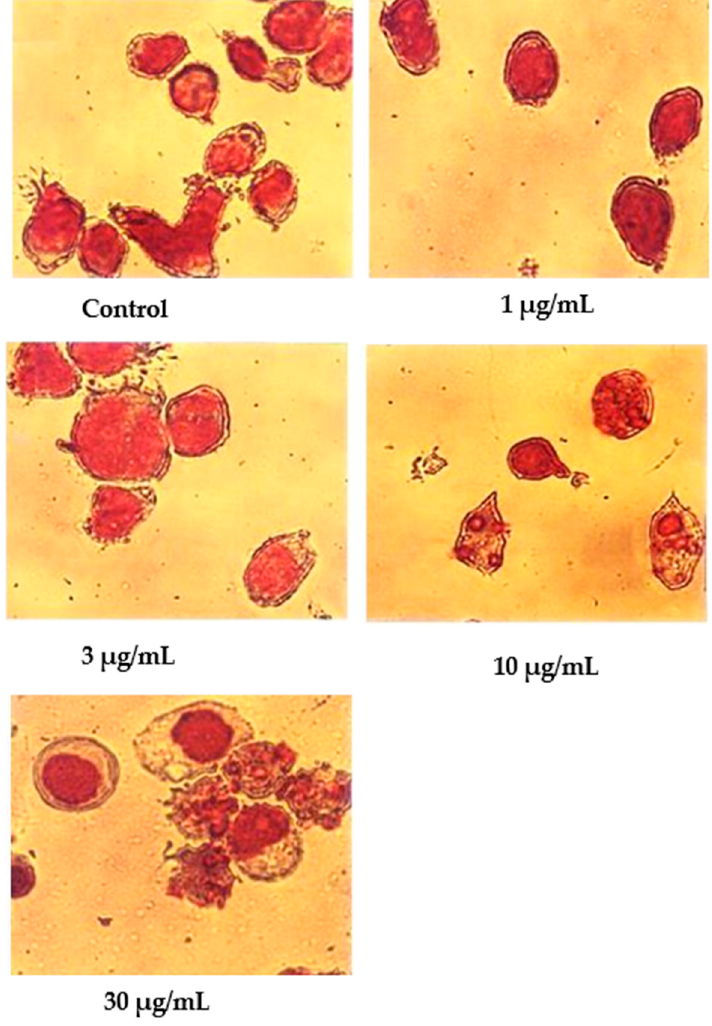
Figure 6. Wright’s-stained CEM-SS cells without treatment (control) or treated with different concentrations of nordamnacanthal for 24 h (200× magnification).